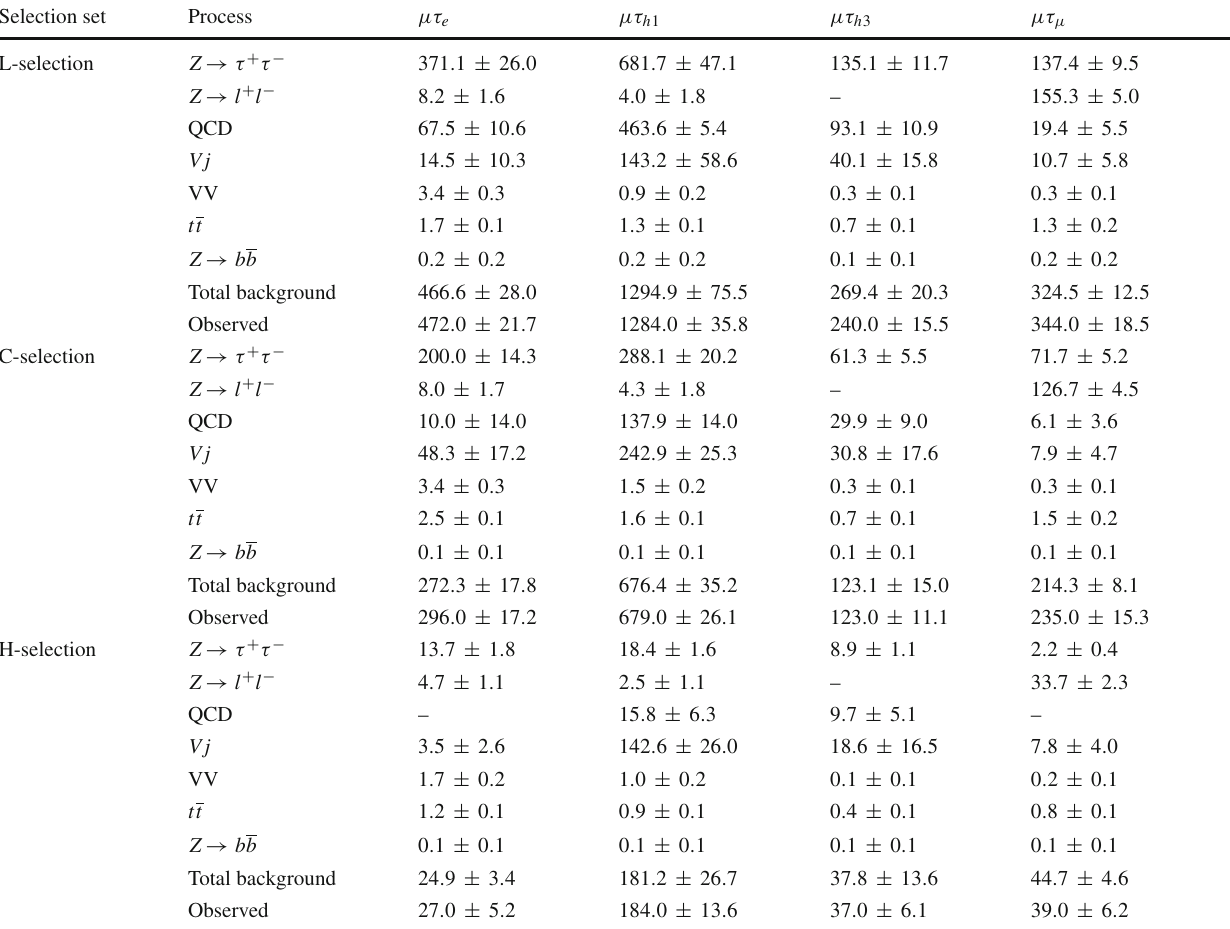
Table 2 Expected number of background candidates from each component, total background with uncertainty, and number of observed candidates with statistical uncertainty, from each decay channel and selection set Selection